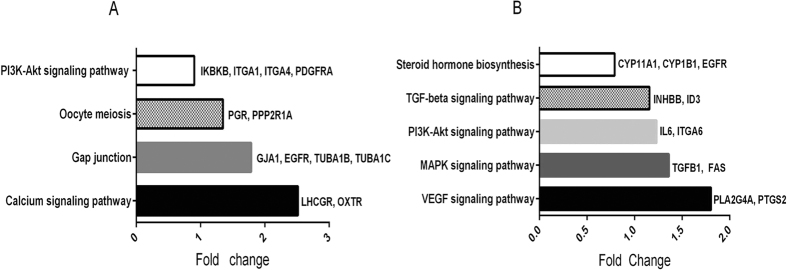
Significantly signaling pathway involved differentially expressed genes.The threshold of Padj was set at < 0.05 to find significantly signaling pathway. The listed genes are the differentially expressed genes analyzed in our study in each pathway. (A) Significantly signaling pathway of oocytes comparing PCOS patients with non-PCOS patients. (B) Significantly signaling pathway of CCs comparing PCOS patients with non-PCOS patients.